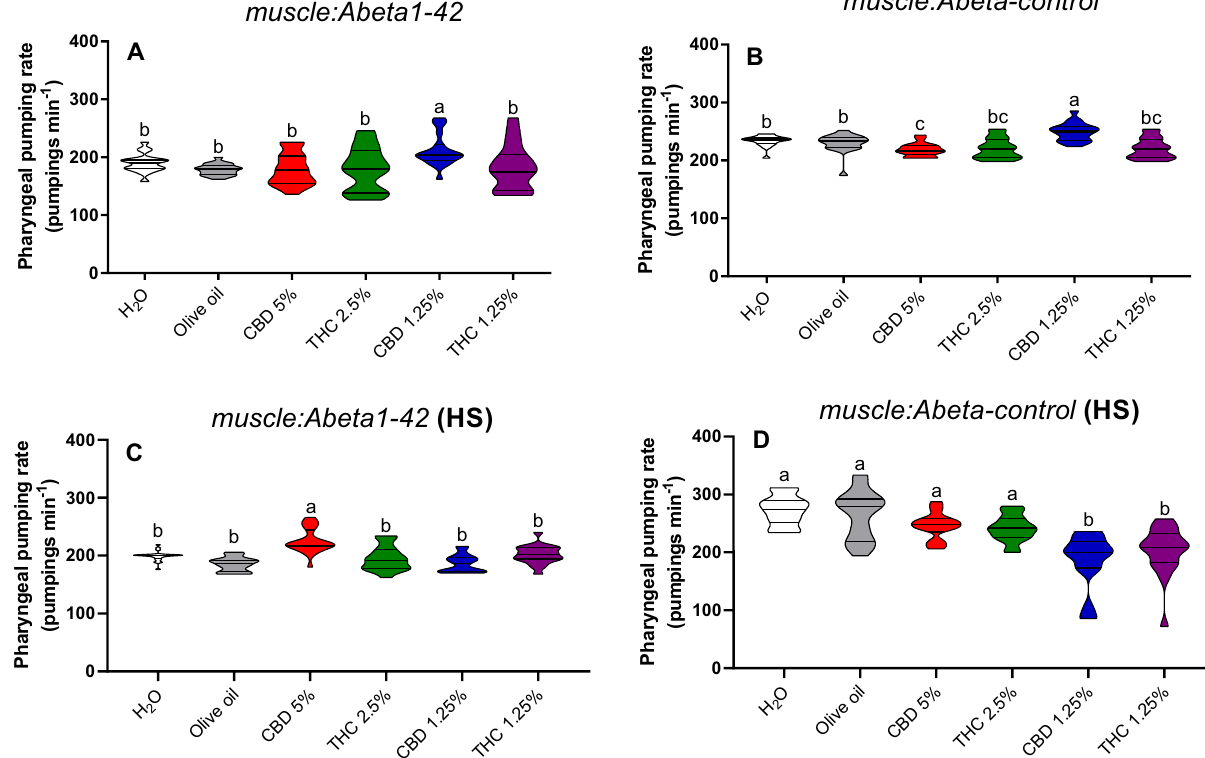
Figure 7. Pharyngeal pumping rate in non-stressed ( A , B ) and heat-stressed (HS) ( C , D ) C. elegans muscle:Abeta1-42 and muscle:Abeta-control transgenic strains. Data are expressed by the mean ± standard error (SEM). Means followed by the same letter are not significantly different according to Tukey’s test ( p > 0.05) ( B ) or Dunn’s test ( p > 0.05) ( A , C , D